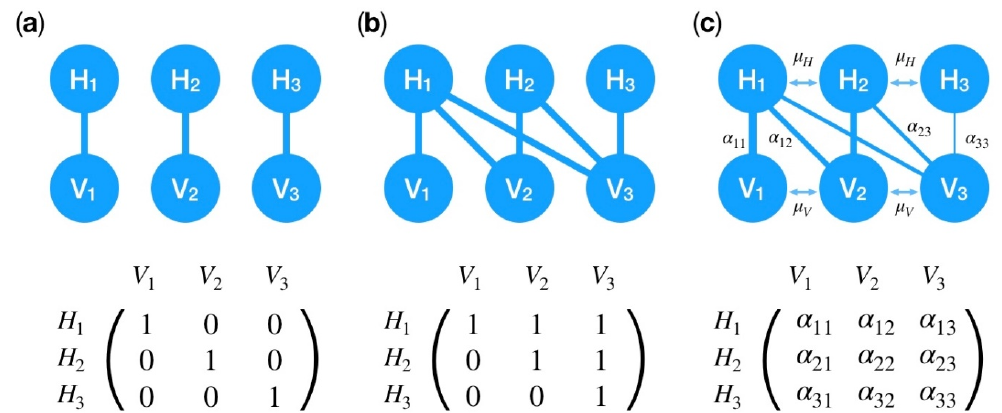
Figure 2. Overview of possible types of coevolutionary interactions between host genotypes ( H i ) and virus genotypes ( V j ). The top row shows a graphical representation of potential interactions between different host and parasite genotypes. Lines indicate that a virus with genotype j can infect a host with genotype i . The corresponding infection matrices are shown in the bottom line. Entries in the infection matrix which are equal to 0 ( 1 ) indicate that the host genotype in row i is fully resistant (susceptible) to the virus genotype in column j . ( a ) In a matching-allele system each virus genotype can successfully infect only one host genotype. ( b ) In gene-for-gene systems there is one universally infective virus genotype (here V 3 ) which is able to infect all host genotypes. Most coevolutionary interactions fall onto a continuum between these two extremes and can be captured in a correspondingly parameterized infection matrix as illustrated in ( c ). α ij reflects the rate of success for virus genotype j to infect host genotype i . Every α ij can take values between 0 and 1 . Genotype-altering mutations happen at rate µ H in the host and µ P in the